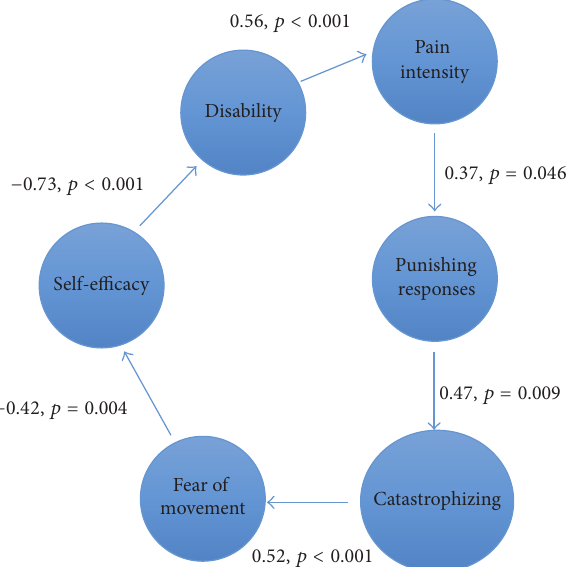
Figure 1: Results in beta and 𝑝 values from linear regression analyses based on the modified fear-avoidance model including functional self-efficacy and the interpersonal environment; punishing responses from a spouse/ intimate